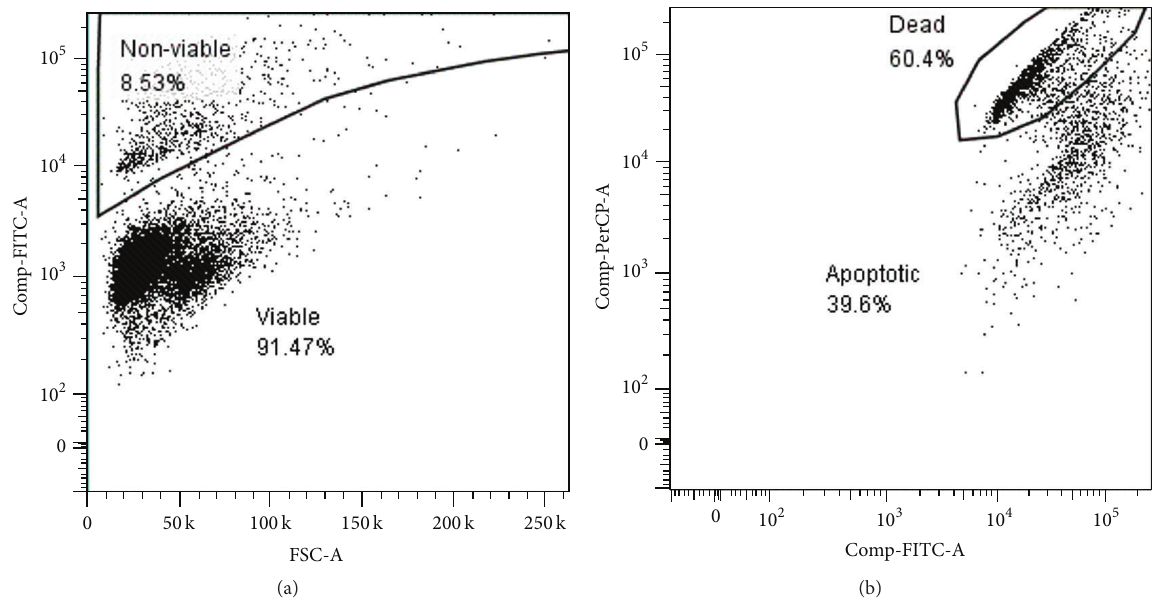
Figure 2: Gating of viable, dead, and apoptotic MSCs. (a) After excluding debris, the CellEvent™ caspase-3/7 FITC positive cells were gated as nonviable, and the rest as viable cells. (b) Nonviable cells were then gated as dead (SYTOX®AADvanced™ positive) and apoptotic cells (the